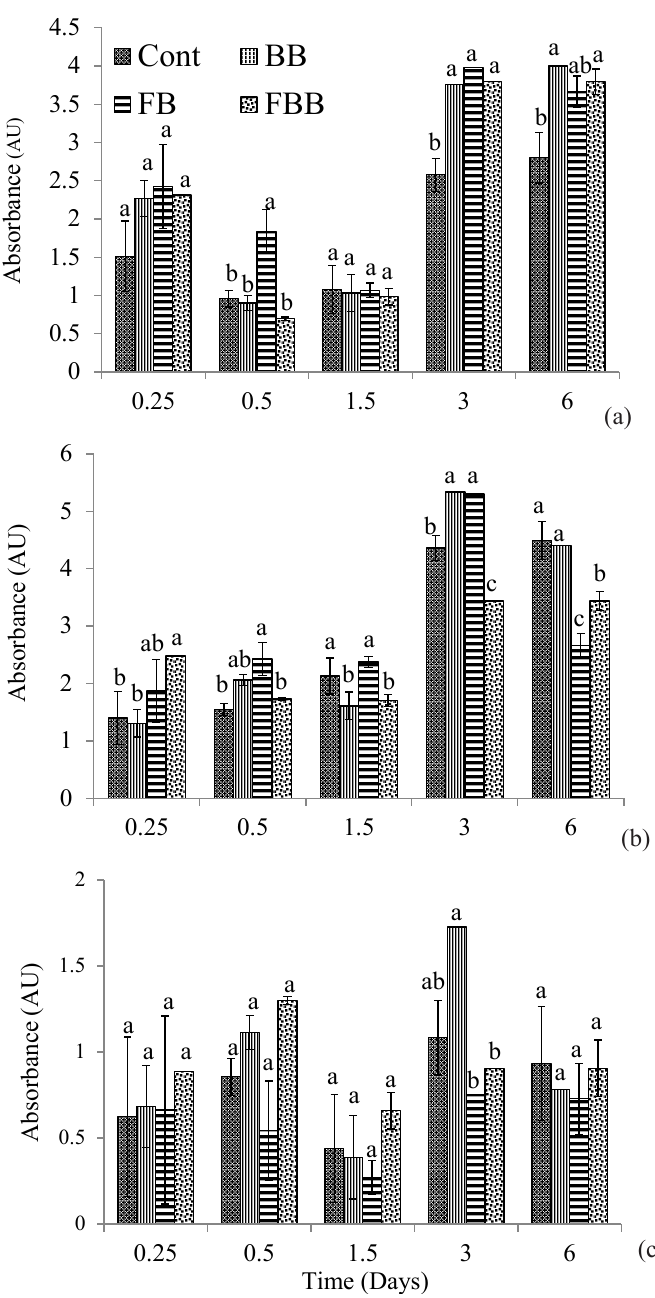
Figure 1: Differences of concentrations of functional polysaccharides (a), amides (b) and fatty acids (c) of biofilms in four maturity stages 0.5, 1.5, 3 and 6 days. BB - Bacterial biofilm, FB - Fungal biofilm, FBB - Fungal-bacterial biofilm. Data were gathered from polysaccharide (900 – 1,200cm -1 ), amide (1,500 – 1,800 cm -1 ) and fatty acids (2,800 – 3,000cm -1 and1, 400 -1,500 cm -1 ) windows of FTIR spectrum. Columns headed by the same letter in the same harvest are not significantly different at 5% probability level. AU absorbance